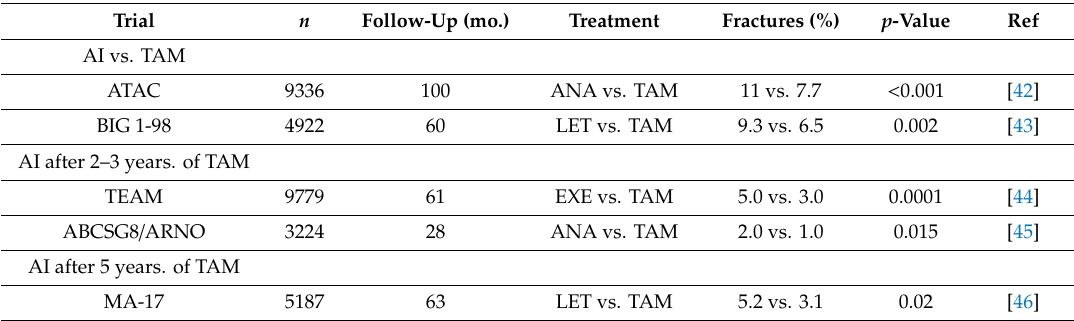
Table 2. Fractures rates in randomized trials of aromatase inhibitors versus tamoxifen. Trial n Follow-Up